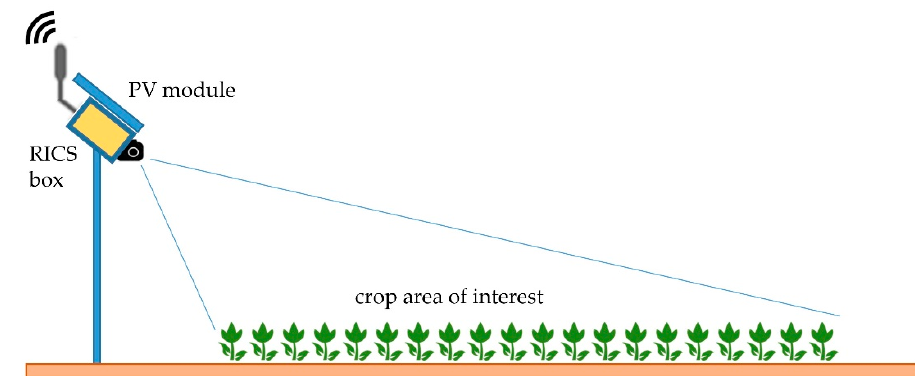
Figure 2. Schematic configuration of a remote vision node or RICS box. The placement of the box is configurable and determines the part of the crop that is visible under the area of interest.